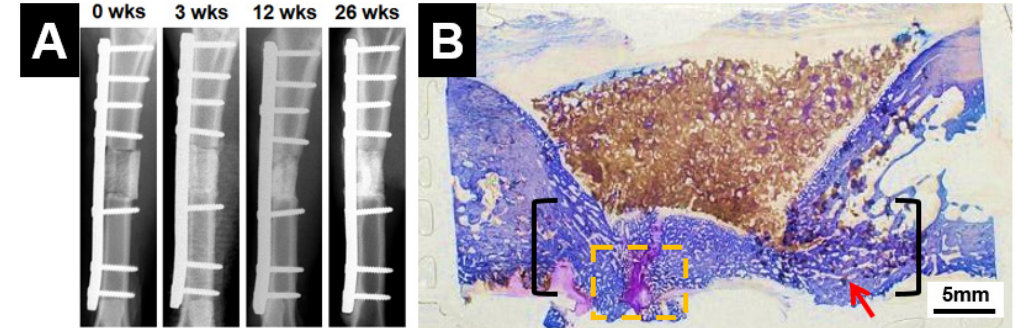
Figure 6. Baghdadite scaffolds achieved effective repair of a critical-sized segmental defect in the sheep tibia, with ( A ) radiographic evidence of clinical union at the bone-scaffold interface; and ( B ) histological evidence of significant and almost complete bridging of the defect, as well as bone infiltration and remodelling within the scaffolds [110]. Adapted by permission of IOP Publishing, Copyright © 2016.